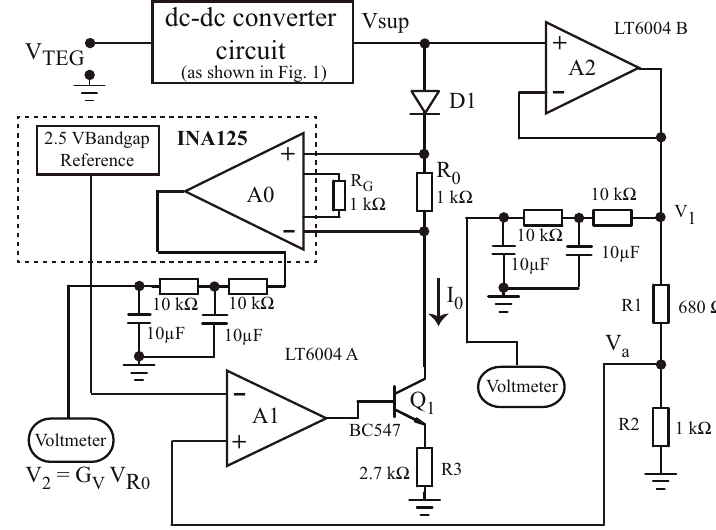
Figure 5. Measurement circuit